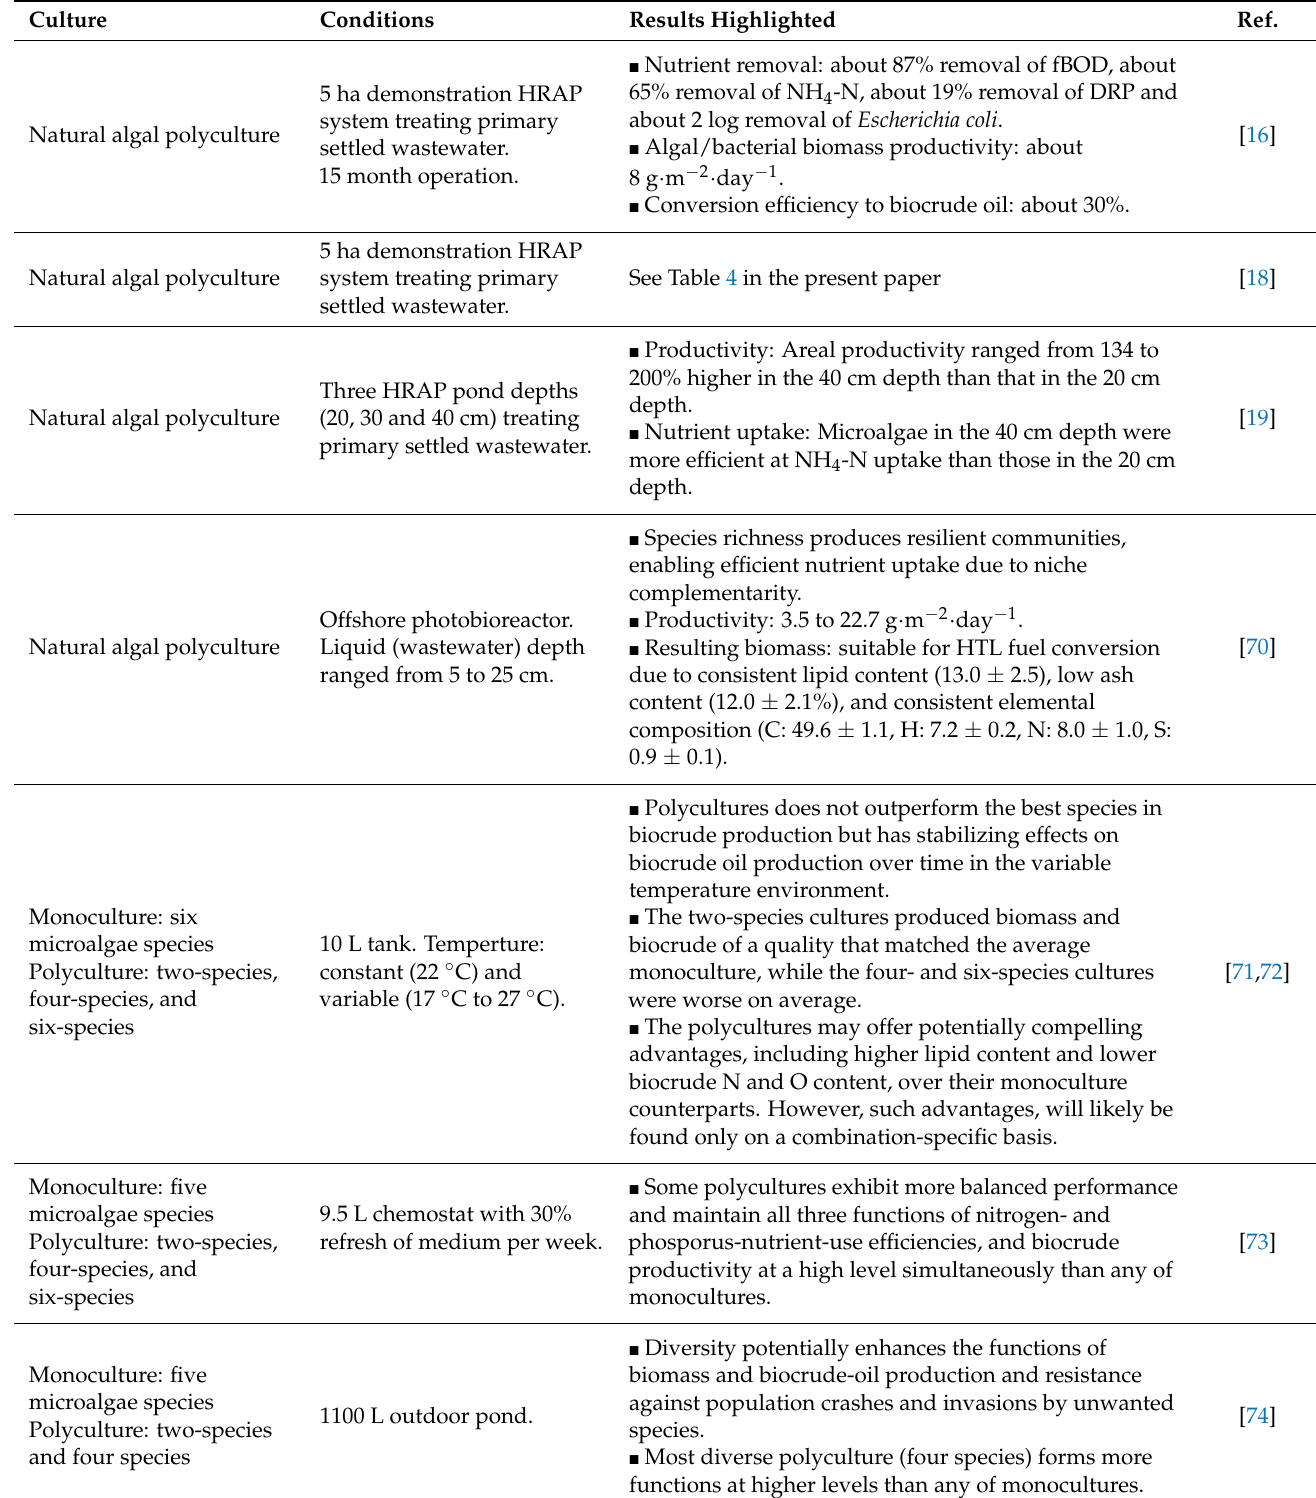
Table 3. Polyculture performances for biomass production, nutrient use and removal, and biocrude production. Culture Conditions Results Highlighted